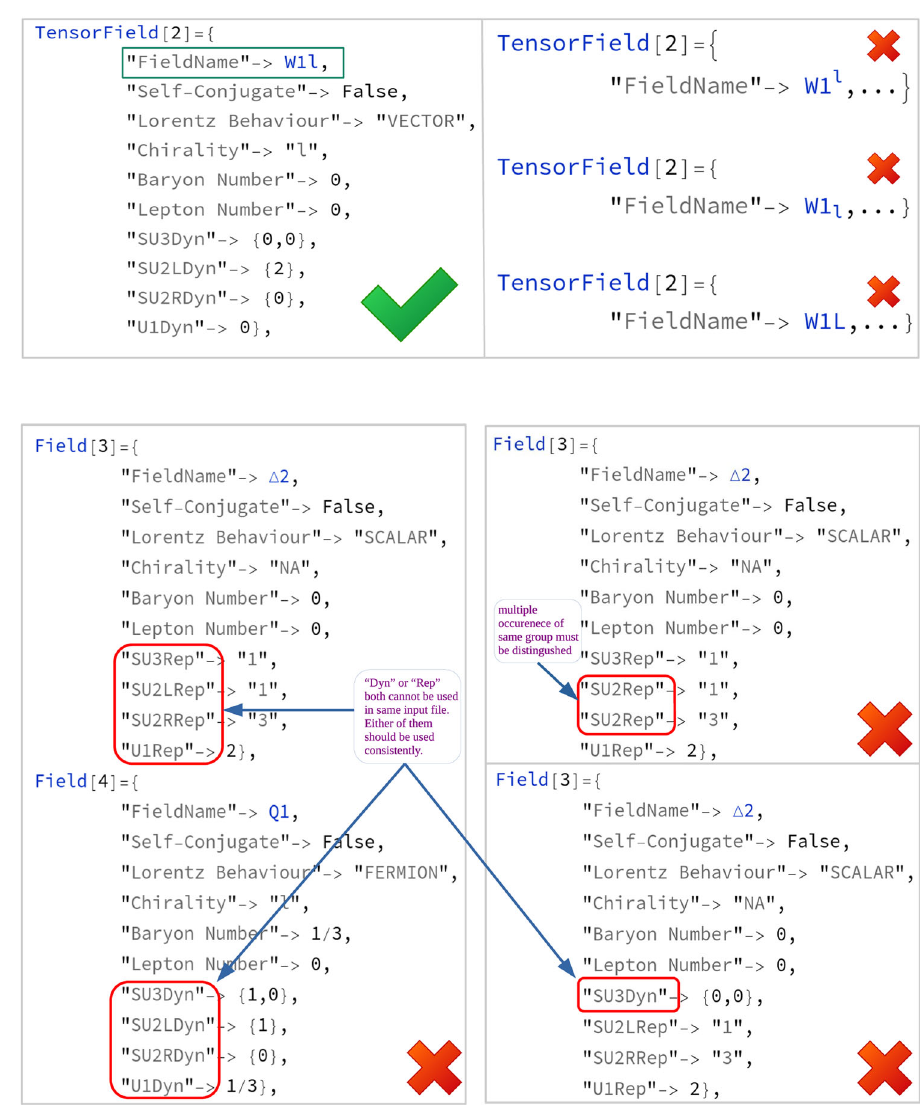
Fig. 7 Correct and incorrect ways of encoding the details of the chiral nature of the field strength tensors in the "FieldName"